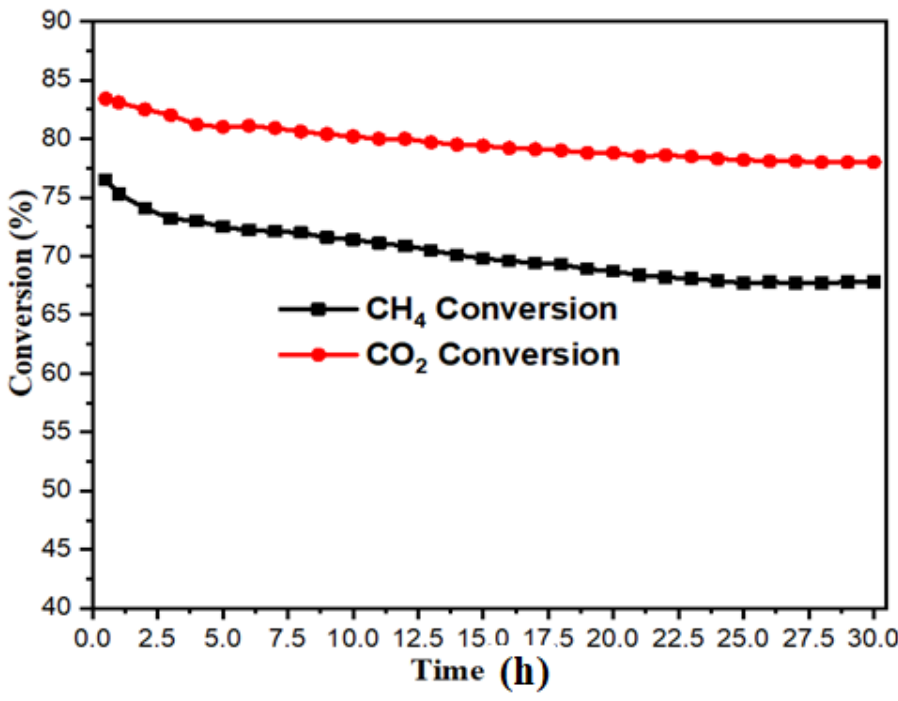
Figure 7. Long time-on-stream for perovskite catalyst calcined at 725 ° C, using 0.05 g of catalyst with GHSV of 84 L/g/h; T = 700 °C.